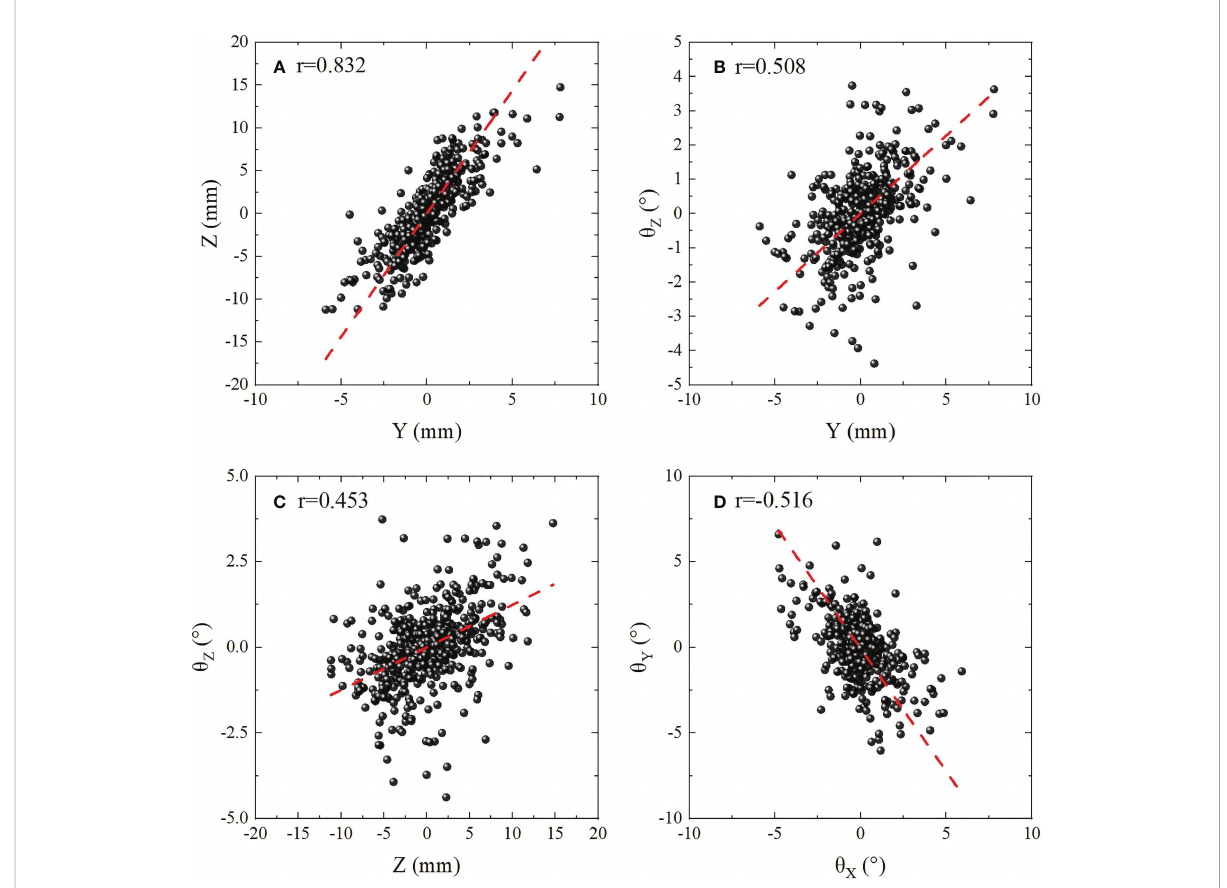
FIGURE 4 Scatter plot showing the correlation between six dimensional movements with | r |>0.4 . (A) ( Z , Y ) with r =0.832 for indicates strong correlation. (B – D) ( Y , q Z ), (Z, q Z ) and ( q X , q Y ) with 0.4<| r |<0.6 indicates medium correlations. The red dashed lines are linear fi